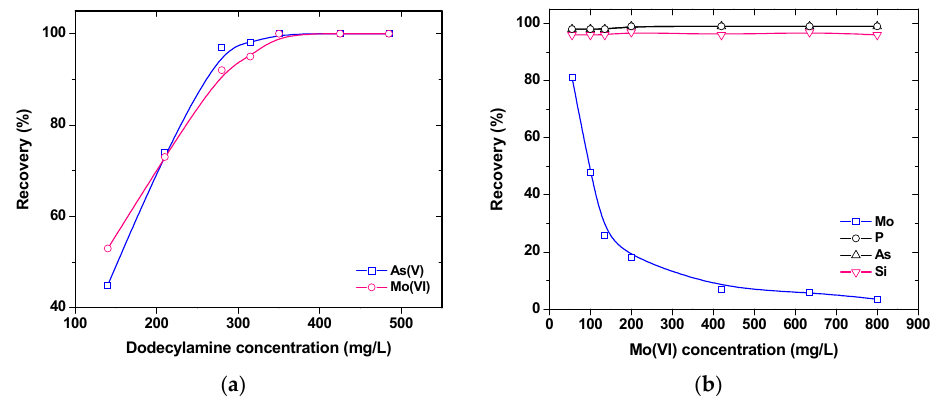
Figure 1. ( a ) Ion flotation of an aqueous mixture of arsenic–molydbenum anions by the addition of dodecylamine at pH 3.6, at different initial concentrations of the collector. Reprinted with permission; copyright Taylor & Francis [31]. ( b ) Adsorbing colloid flotation of the separation of molybdate oxyanions from mixtures by dodecylamine at pH 9: Effect of the initial molybdate concentrations on the selective separation of phosphates, arsenates, and silicates; the latter, as impurities, were initially present in low concentrations. Reprinted with permission; copyright Elsevier